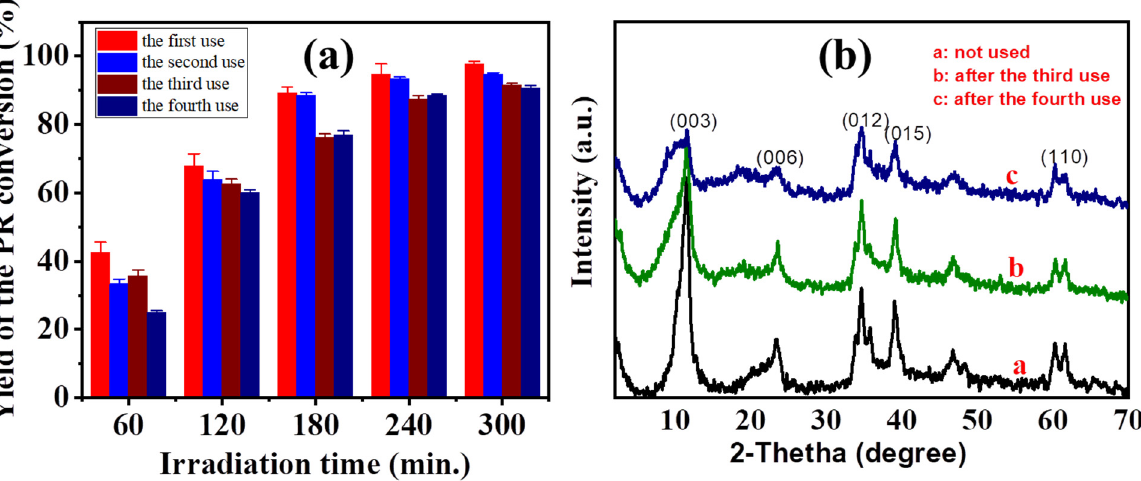
Figure 12. The efficiency of PR degradation after four times of catalyst reuse ( a ) and XRD patterns of CuH–3.5 material after four reuses ( b